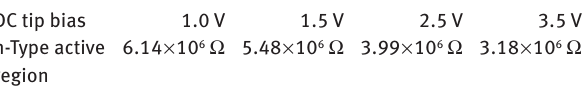
Table 1: SSRM resistance across the active region of a terahertz QCL device at DC tip bias voltages of 1.0, 1.5, 2.5, and 3.5 V.